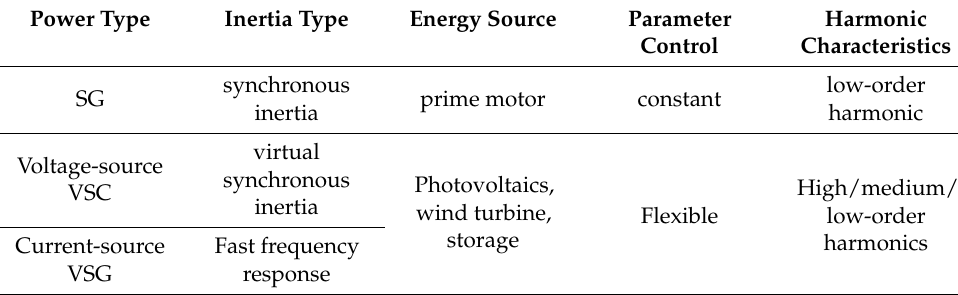
Table 1. Characteristic comparison between VSG and